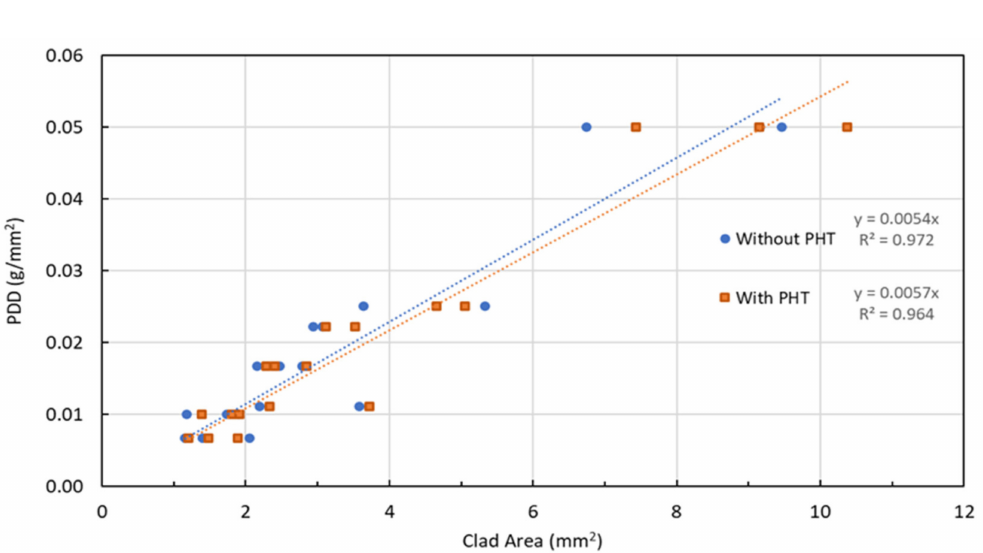
Figure 9. Relationship between the cladding area and the value of the PDD parameter.